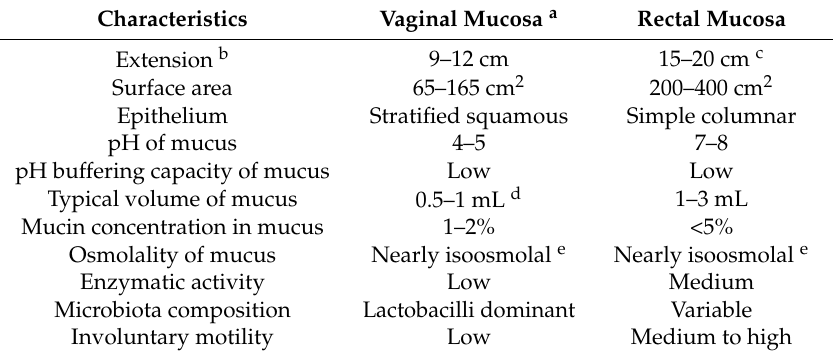
Table 1. Typical characteristics of vaginal and rectal mucosae (revised in